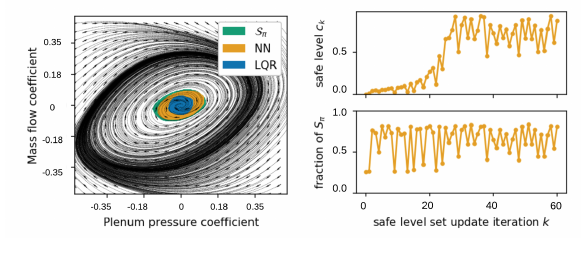
Figure 9: (a) Safe Lyapunov candidate level sets. (b) Training behaviour of the NN candidate. This is the same control law as in Figure 6, only that 40 more iterations have been